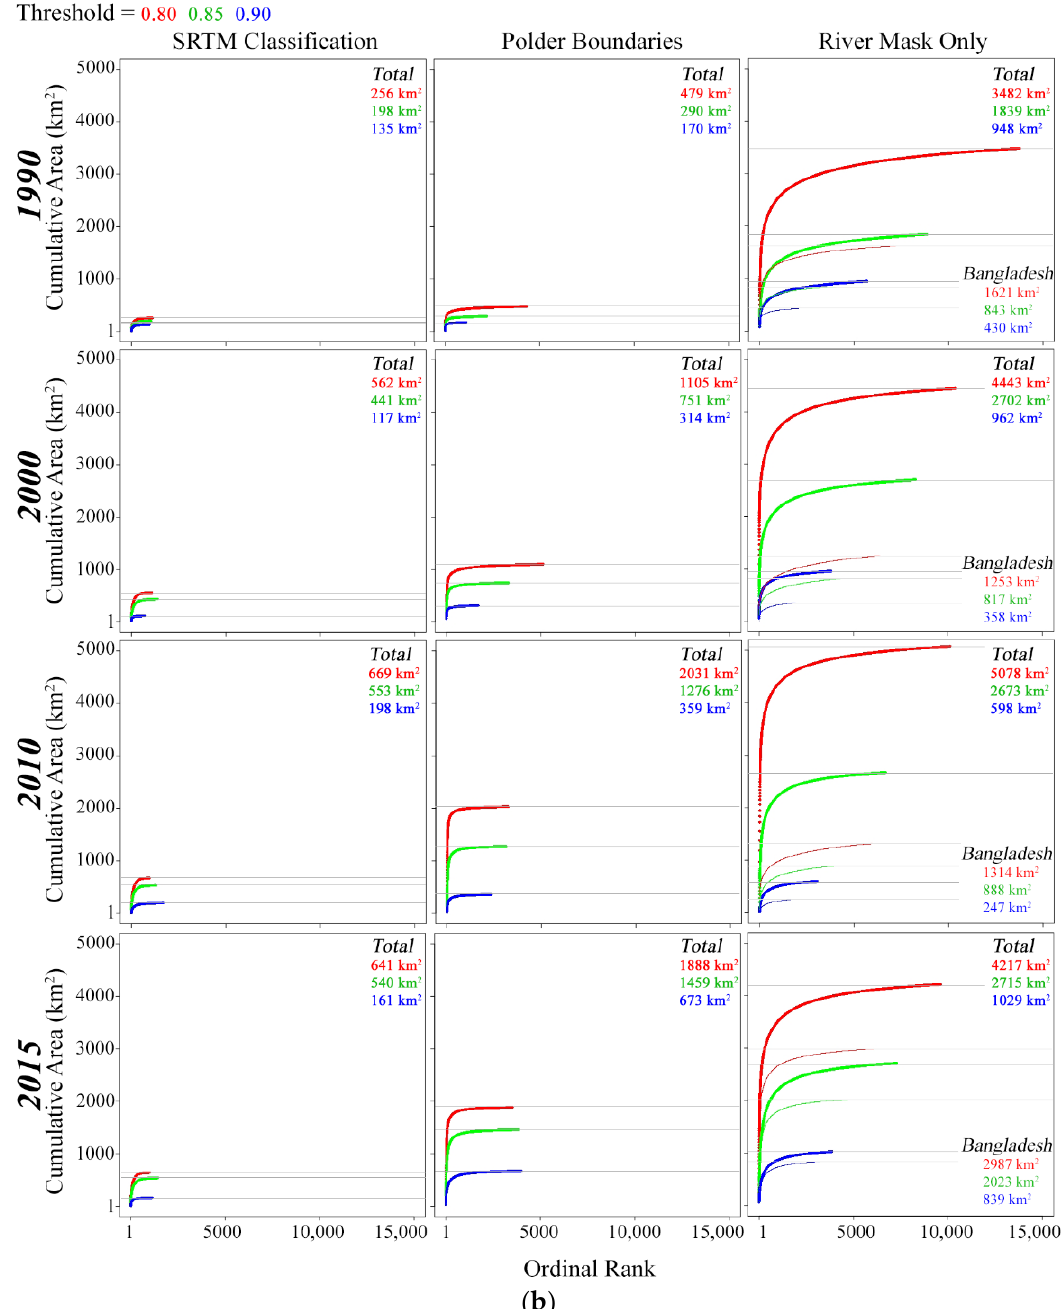
Figure 11. ( a ) Evolution of aquaculture spatial networks between 1990 and 2015. Three different regions were used for this analysis: locations classified as ponds in February 2000 by SRTM slope and elevation (left column), regions within the administrative units of Bangladeshi polders (center column), and a large region of the lower delta with only rivers and ocean masked out (right column). Dark fractions for each image were segmented at thresholds of 0.80 (red), 0.85 (green), and 0.90 (blue). One-to-one lines shown in gray. Note logarithmic axes. ( b ) Evolution of cumulative size distributions of aquaculture spatial networks between 1990 and 2015. The same three regions and dark fraction thresholds were used as in Figure 10a. Overall sums given in the upper left corner of each plot and indicated by horizontal lines. Cumulative distributions for the portion of the “River Mask Only” study area within Bangladesh shown in thin curves and lighter gray horizontal lines. Cumulative totals for the Bangladesh-only analysis given in the lower right corner.